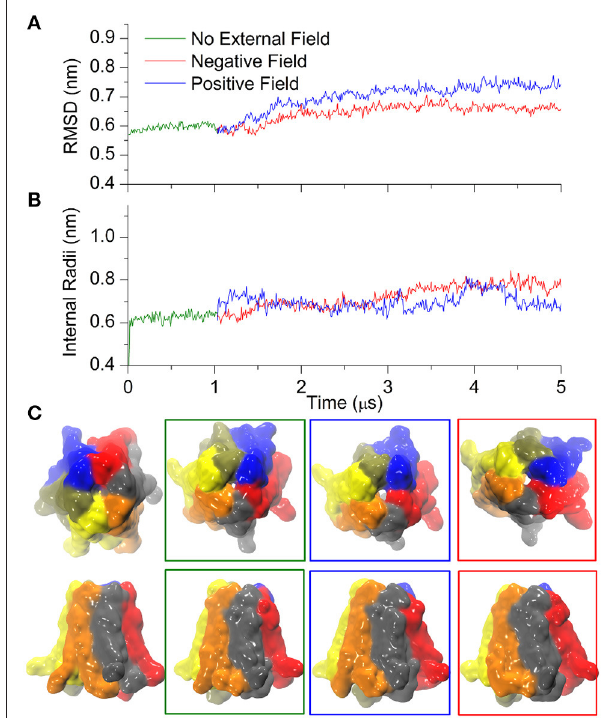
FIGURE 3 | Cx26 under external electric field. (A) RMSD on the Cx26 Connexon in absence (green) and presence of an external field (red: negative or polarizing; blue: positive or depolarizing). The external field in either direction was applied after 1 µ s of simulation in the absence of an external field. The green trace corresponds to the same simulation presented in Figure 1 , which is shown here as a reference. (B) Time series of the maximum constriction size at the pore lumen measured at the level of Lys41 in the absence and in the presence of external field. (C) Solvent accessible surfaces of initial (left) and final conformers colored by chain in top and side views. The color code of the external frames is the same as in (A,B) .